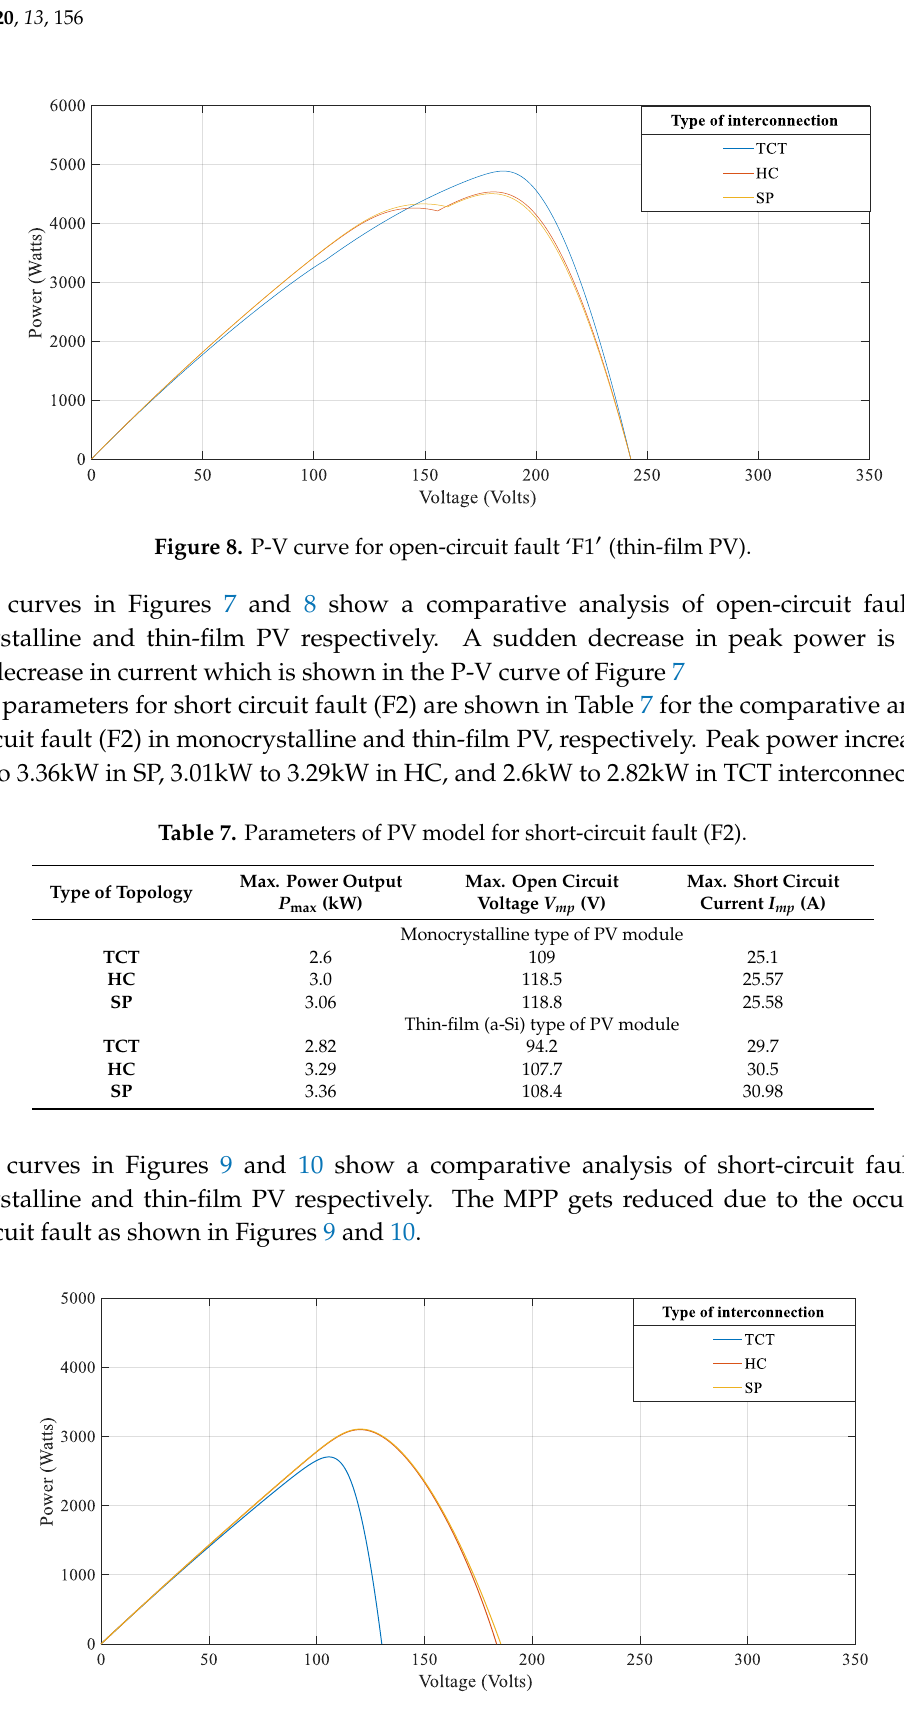
Figure 7. P-V curve for open-circuit fault ‘ F 1′ (monocrystalline PV).